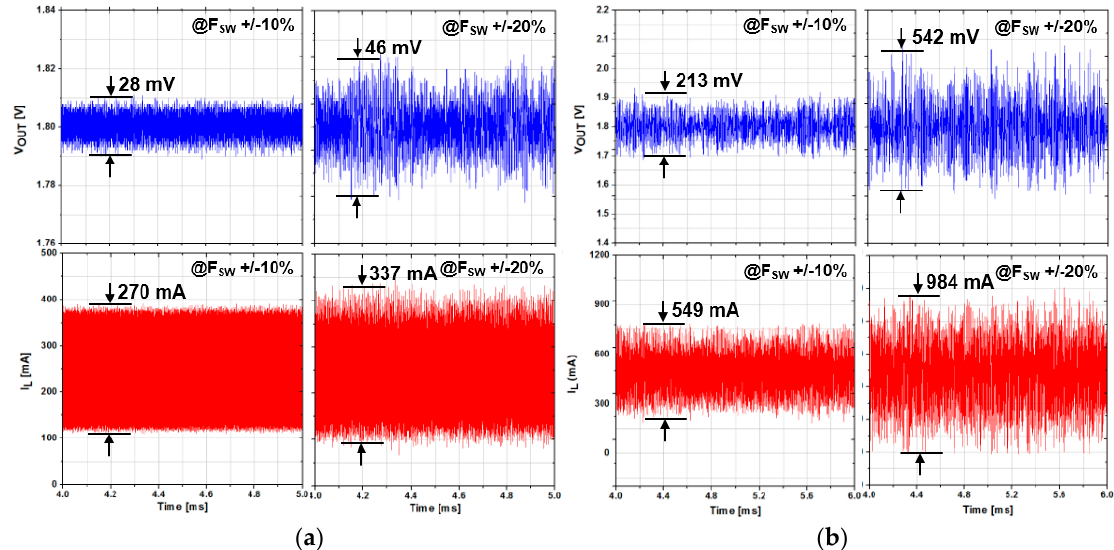
Figure 13. Simulated output voltage and inductor current waveform in chaotic mode: ( a ) Using ramp generator with slope modulation; ( b ) Ramp generator with peak modulation. Standard mode: V OUT_ripple : 13.36 mV, I L_ripple : 257 mA (@ Simulation condition: Io = 250 mA). (F SW +/ − 10% (1.08 MHz to